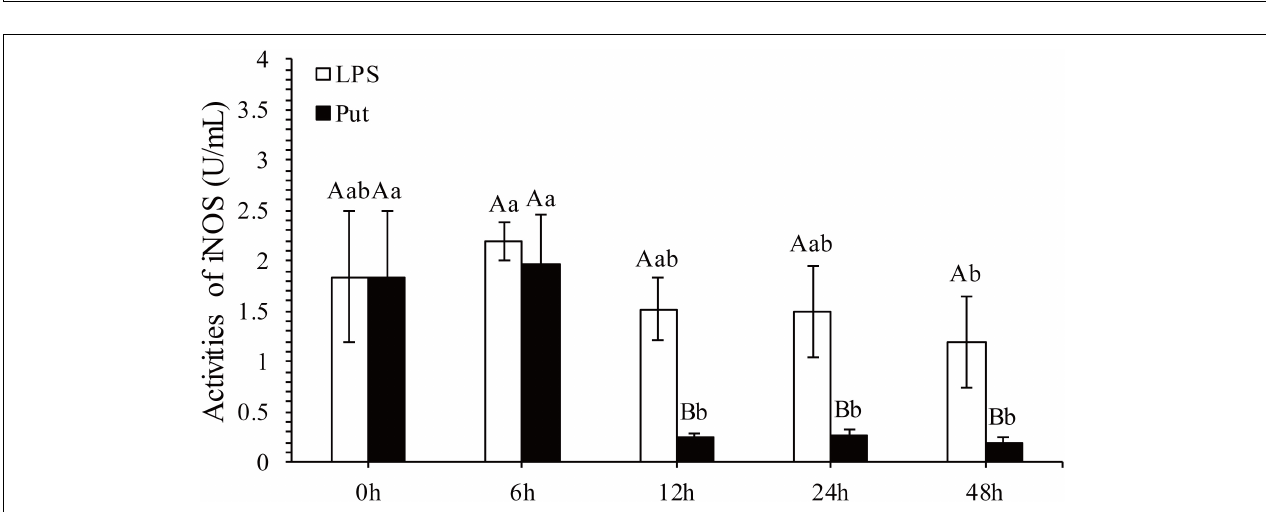
FIGURE 3 | Detection of iNOS activity in serum after the putrescine treatment. Values are shown as mean ± SE ( N = 5). iNOS, inducible nitric oxide synthase. Lowercase letters represent differences at different time points in the same groups, and capital letters represent differences in the different groups at same time points. Lipopolysaccharide (LPS) group, PBS_LPS; Put group, Put dihydrochloride_LPS.